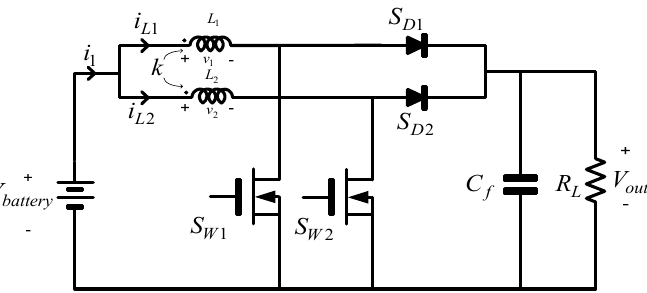
Figure 11. Converter consisting of two interleaved and inter–coupled boost converter cells [24].